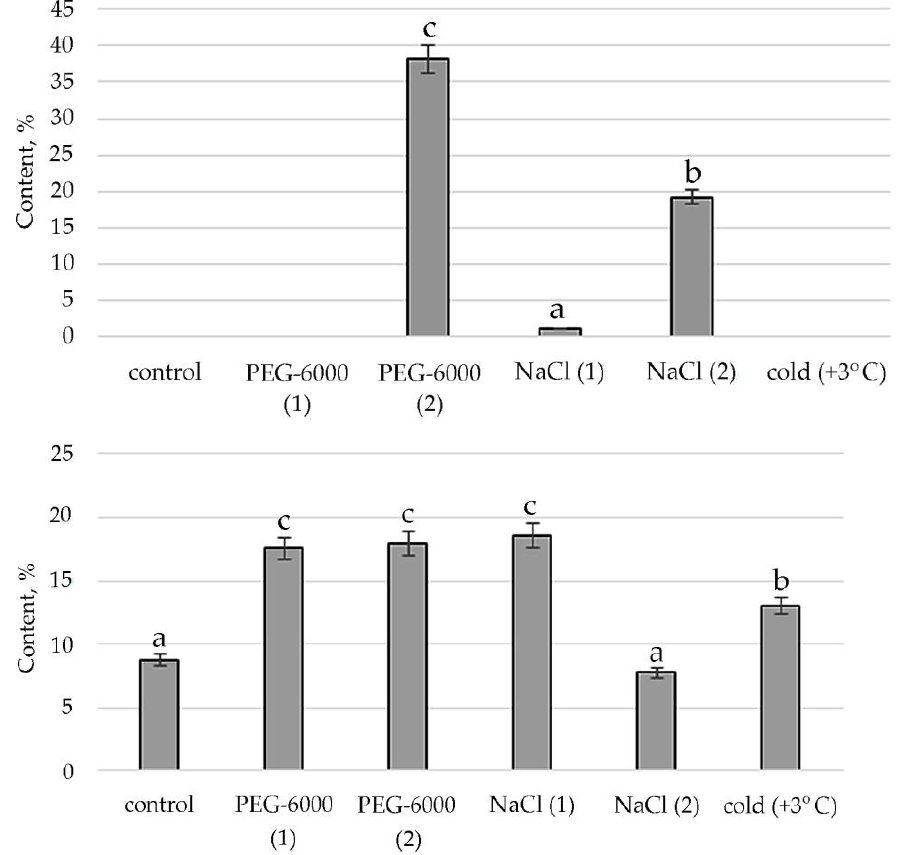
Figure 7. Change in content of 1,2,4-Butanetriol in S. hybridum under stress conditions. Values presented are means (±SD). Different letters above the bars represent significant differences at p ≤ 0.05, n = 3 plants in each of 3 replicates for all treatments.